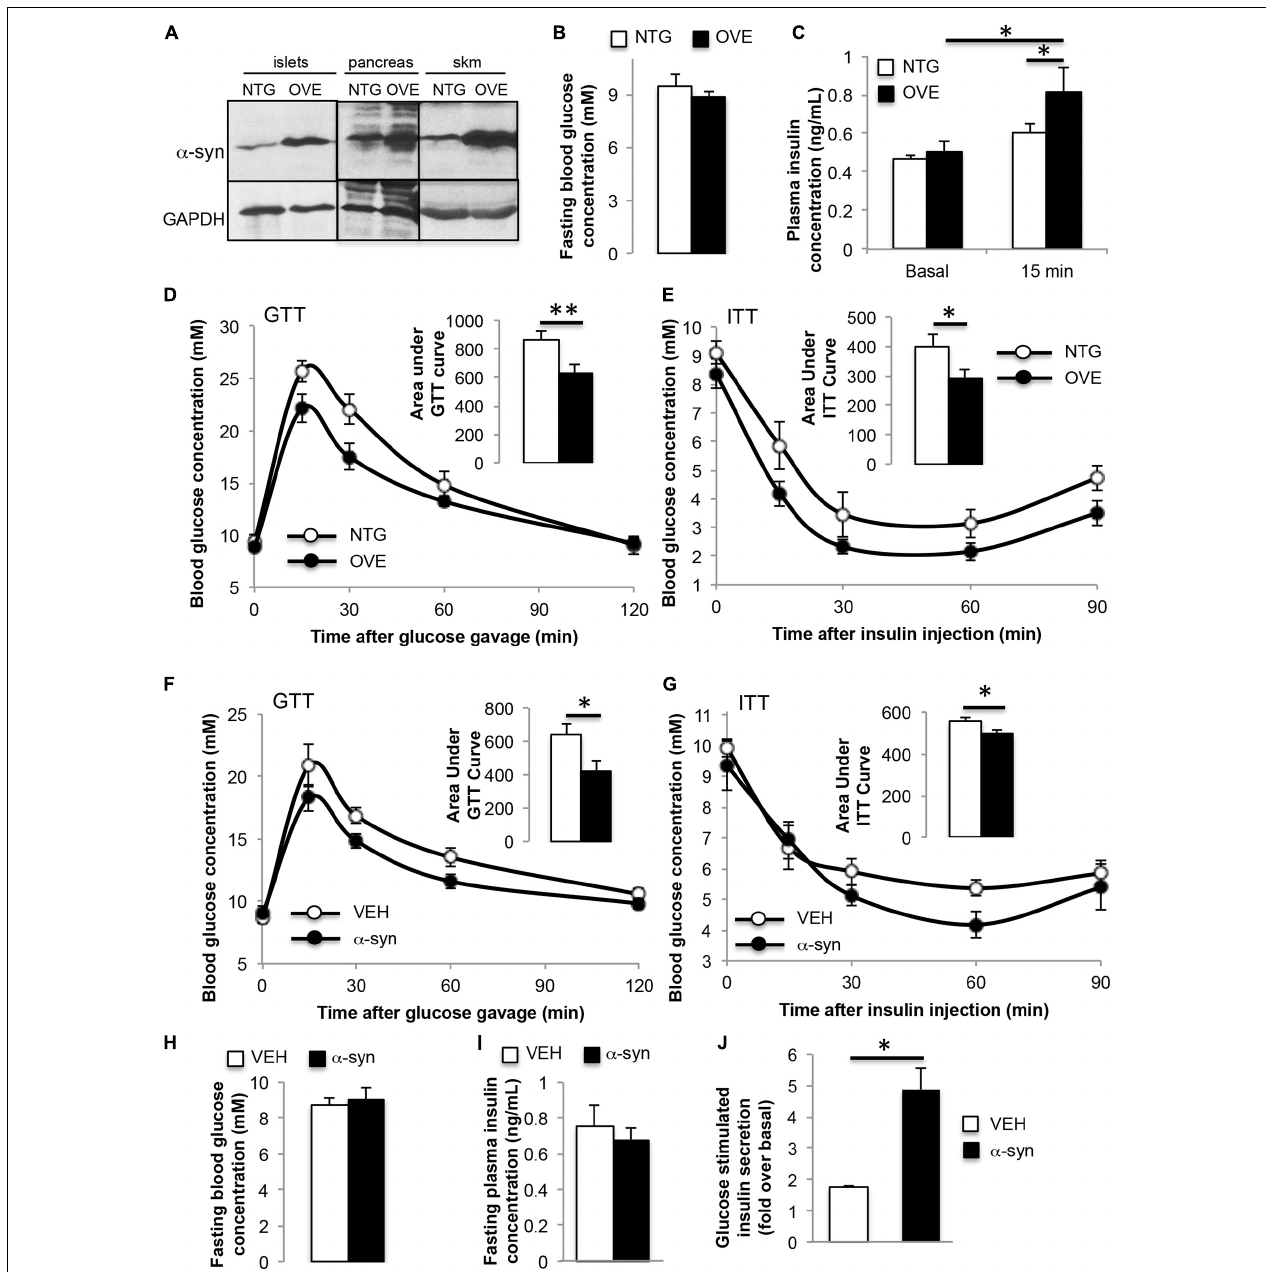
FIGURE 3 | α -syn overexpression or α -syn monomer injection leads to improved glucose tolerance and insulin sensitivity. (A) Western blot analysis showing increased expression of α -syn in transgenic islets, pancreas and skeletal muscle (skm), (B) fasting blood glucose, (C) plasma insulin during oral glucose tolerance test (GTT, 1.5 g glucose/kg body weight) at 0 and 15 min after glucose gavage, (D) GTT and (E) insulin tolerance test (ITT, 0.75 IU insulin/kg body weight) in 4-month old male non-transgenic (NTG, white bars ) and α -syn overexpressing (OVE, black bars ) mice on chow diet [ (B,D,E) : n = 6, (C) : n = 7–10, ∗ p < 0.05, ∗∗ p < 0.01]. (F) Oral glucose tolerance test (GTT, 1.5 g glucose/kg body weight), (G) insulin tolerance test (ITT, 0.75 IU insulin/kg body weight), (H) fasting blood glucose, and (I) fasting plasma insulin 4 weeks after vehicle (VEH, white bars ) or α -syn monomer ( α -syn, black bars ) injections in male wild type mice on chow diet [ (F–I) : n = 7, ∗ p < 0.05]. Mice were treated with two intraperitoneal injections of 50 µ g of α -syn at 2 weeks apart. (J) Glucose-stimulated insulin secretion expressed as fold over basal from wild type islets treated with vehicle, or 1.68 µ g/mL α -syn monomers for 24 h ( n = 4, ∗ p <